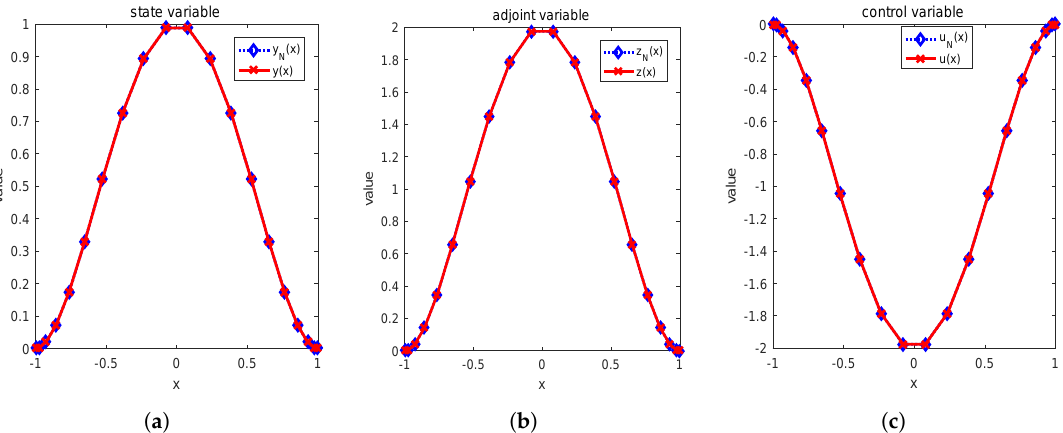
Figure 1. True solutions and numerical solutions. (left) y and y N , (middle) z and z N , (right). Here y N , z N and u N are calculated by Algorithm